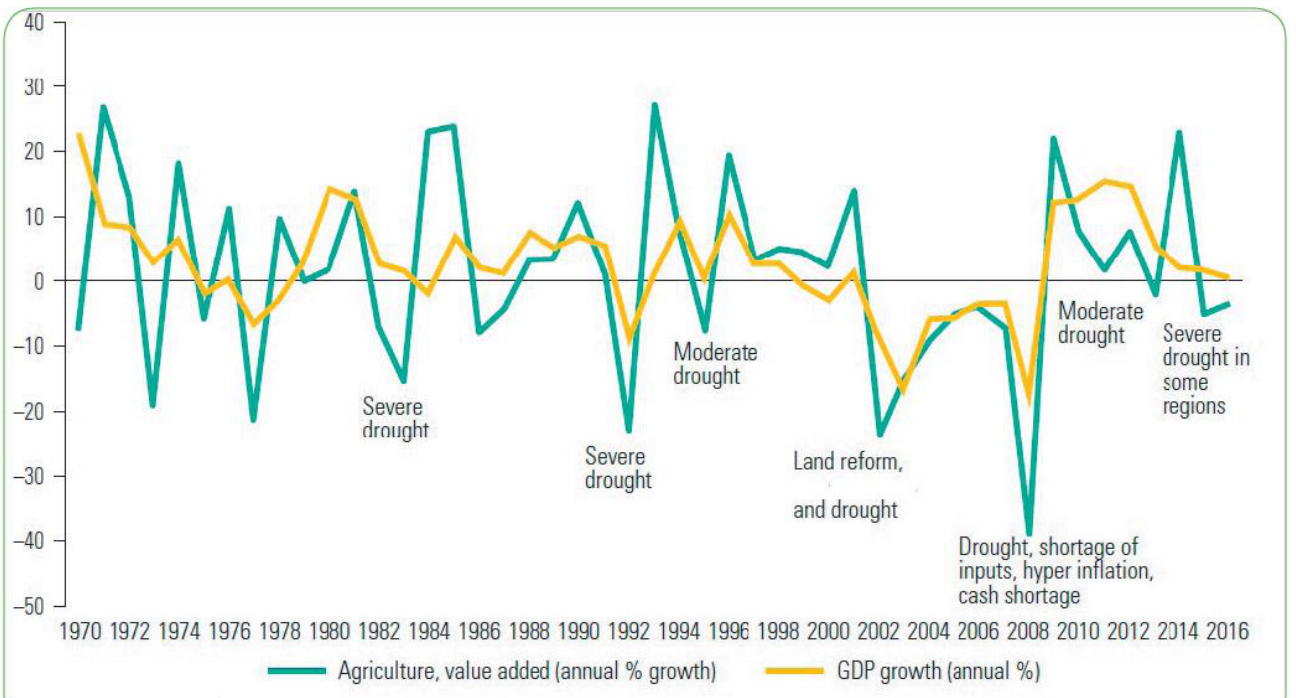
Figure 5. Drought-affected agricultural GDP and overall GDP growth from 1970 to 2016 (source: Green Climate Fund [48]).